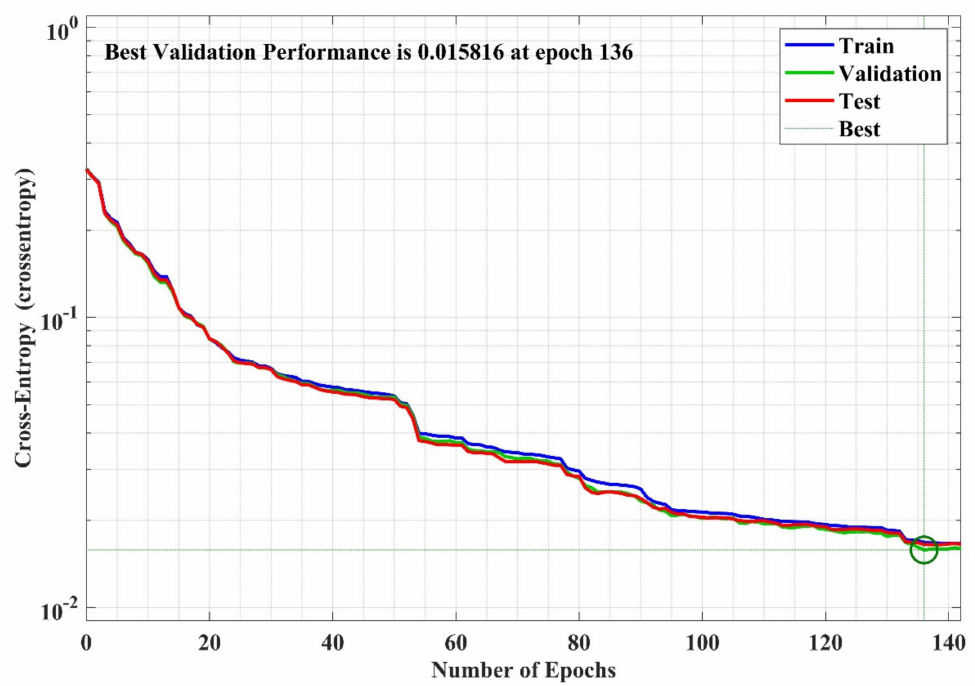
Figure 19. NN performance analysis plot for the training phase of the